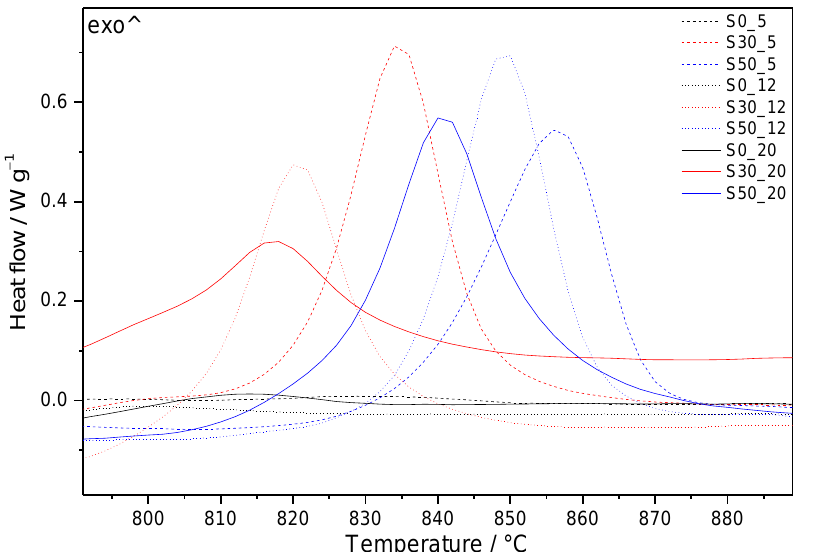
Figure 9. Segment of DSC curves of samples with and without SF additions submitted to different hydrothermal conditions for 7 days.